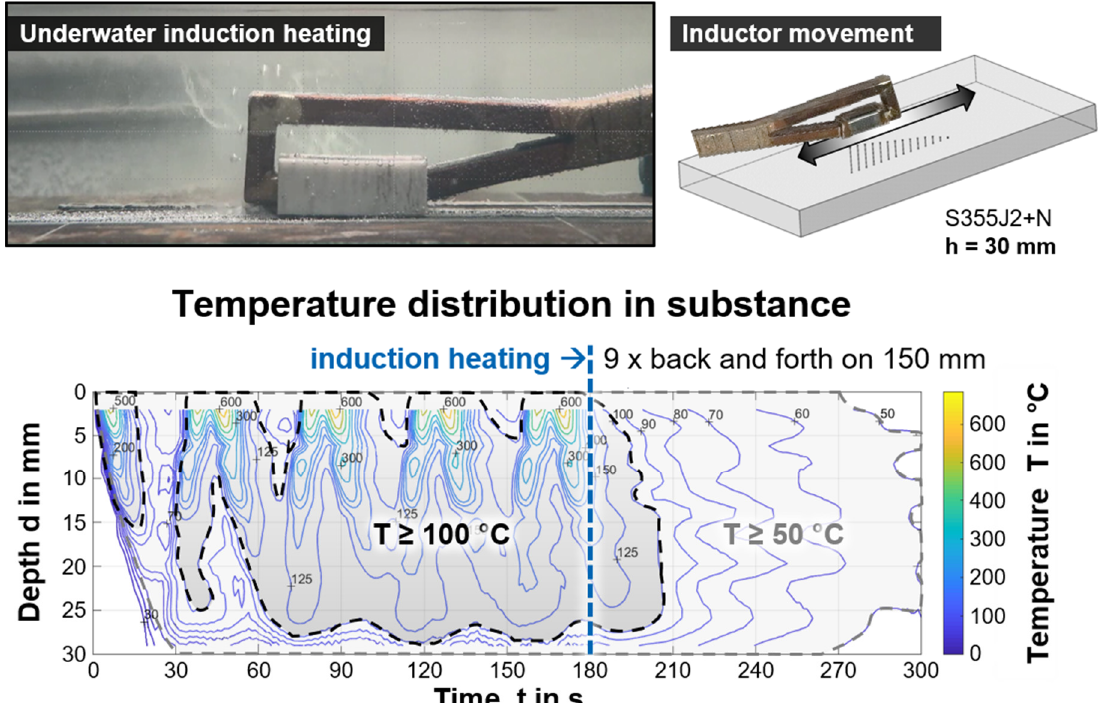
Figure 4. Resulting temperature field in the middle of the longitudinal section of a plate by underwa- ter application of induction heating; th = 30 mm, moving inductor, back and forth with 10 mm/s, total duration 180